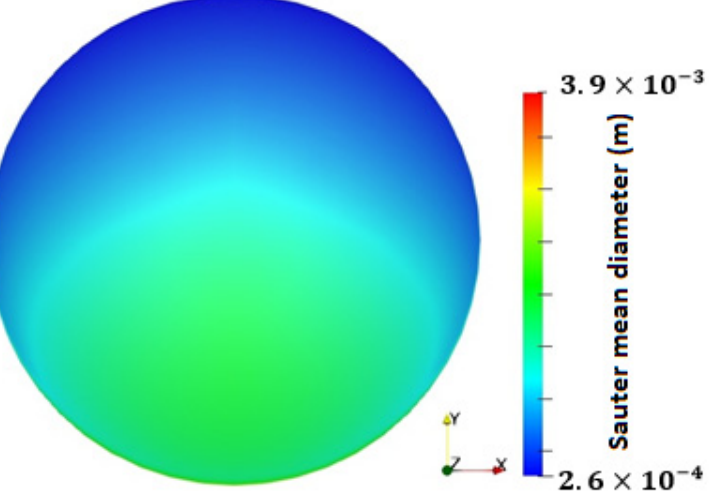
Figure 8. Vertical distribution of Sauter mean diameter across pipe section for test 3 (V = 2 m/s, water cut = 0.1).